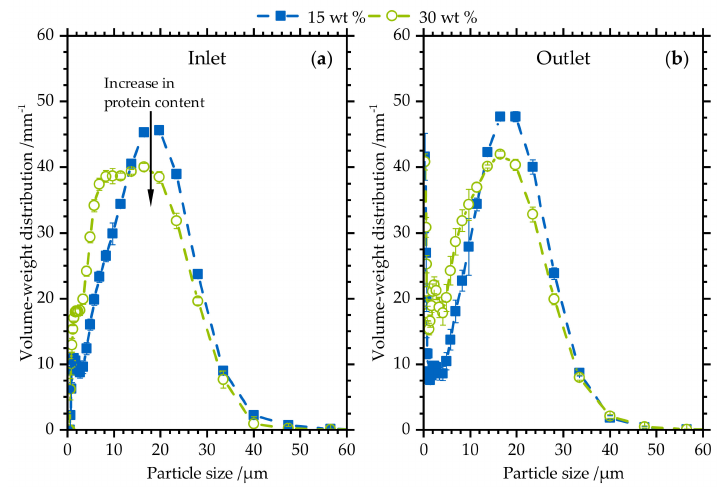
Figure 2. Volume–weight density distribution at ( a ) the Venturi nozzle outlet and ( b ) the outlet of the charging tube. Increasing the initial protein content (from 15 to 30 wt %) refined the particle size distribution. The distributions at the nozzle and tube ends are not obviously di ff